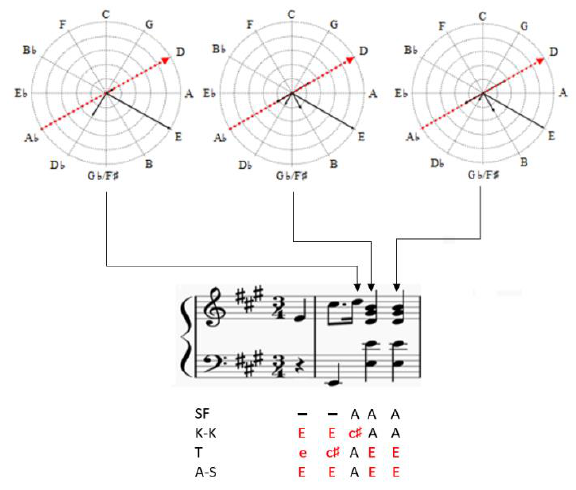
Figure 17. The beginning of F. Chopin’s prelude No. 7, Op. 28, in A-major, where SF is the key-finding method using the signature of fifths and K-K, T, and A-S are the strictly correlational key-finding approaches based on the Krumhansl–Kessler, Temperley, and Albrecht–Shanahan key-profiles, respectively (incorrectly detected keys are marked in red).